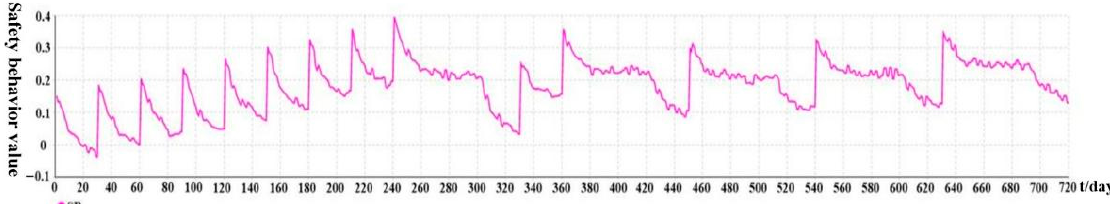
Figure 8. Variation trend of safety behavior over time under passive intervention.